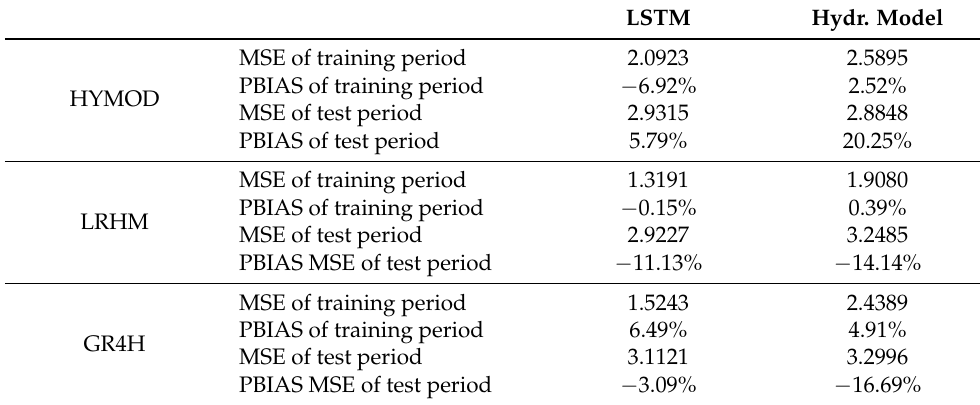
Table 3. Performance indicators of the case study of Bakas